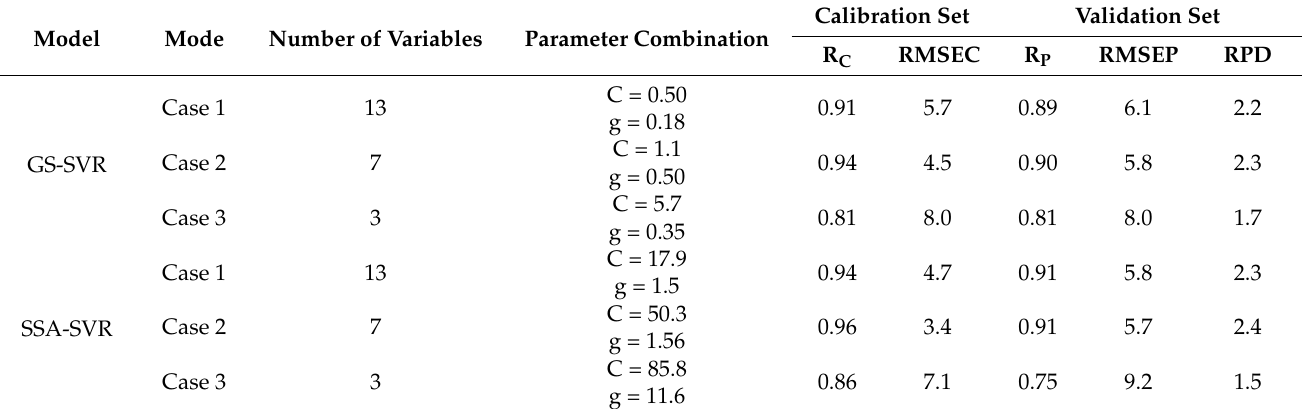
Table 2. Results of the different SVR models based on different combinations of color components.